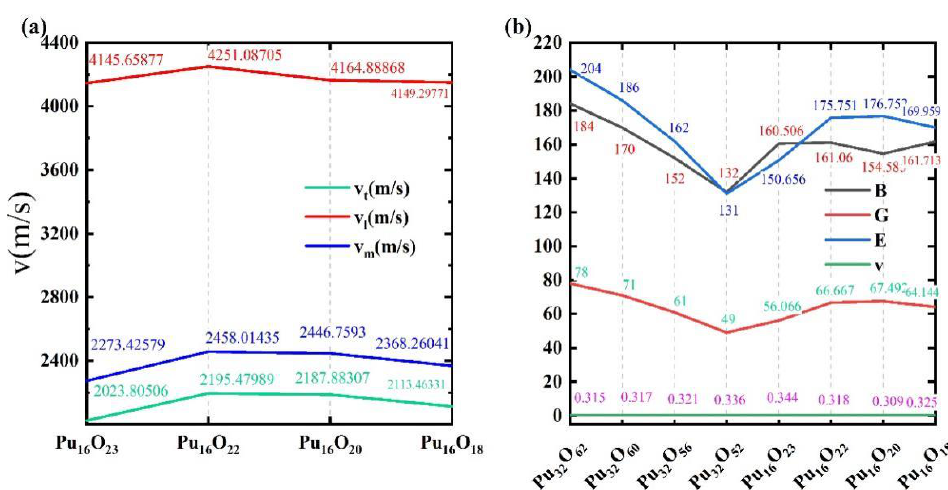
Figure 6. ( a ) Values of average sound velocit y (ν m ), lo ngitudinal wave velocity (ν l ), shear wave velocity (ν t ) of Pu 16 O 23 , Pu 16 O 22 , Pu 16 O 20 , Pu 16 O 18 using VASP. ( b ) Values of the Young’s modulus (E), Bulk modulus (B) and Shear modulus (G) (in GPa), and Poisson’s ratio ( υ ) of Pu 16 O 23 , Pu 16 O 22 , Pu 16 O 20 , Pu 16 O 18 are compared with the values of Pu 32 O 62 , Pu 32 O 60 , Pu 32 O 56 , Pu 32 O 52 calculated by Ghosh [47,48].